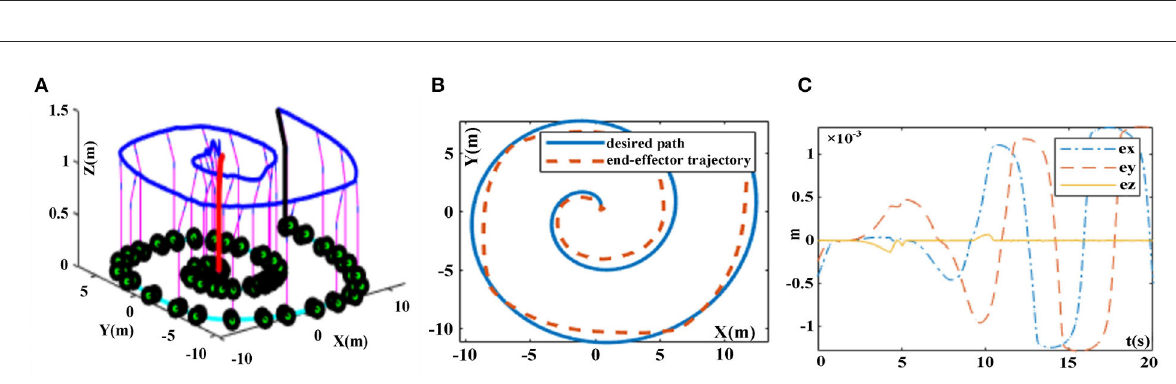
FIGURE18 Trajectory tracking results synthesized by the ZNN-based model (42) in noisy environment. (A) Whole tracking motion trajectories. (B) Desired path and actual trajectory. (C) Tracking